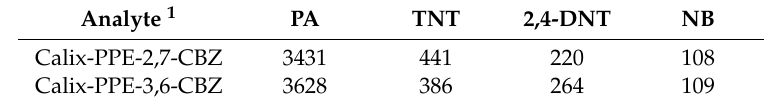
Table 1. Corrected Stern-Volmer constants for Calix-PPE-CBZs with nitroaromatic compounds (NACs) ( K sv /M − 1 ). Analyte